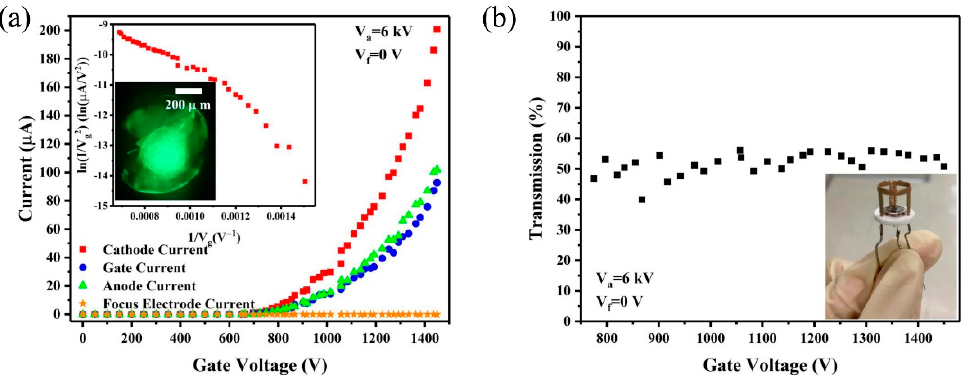
Figure 4. ( a ) I − V curves of the CNT cold cathode electron gun (Inset: corresponding F–N plot and emission image obtained from phosphor screen) ( b ) The gate electron transmission under different gate voltage. (V a = 6 kV, V f = 0 V). Inset shows the picture of the gated CNT cold cathode electron gun.